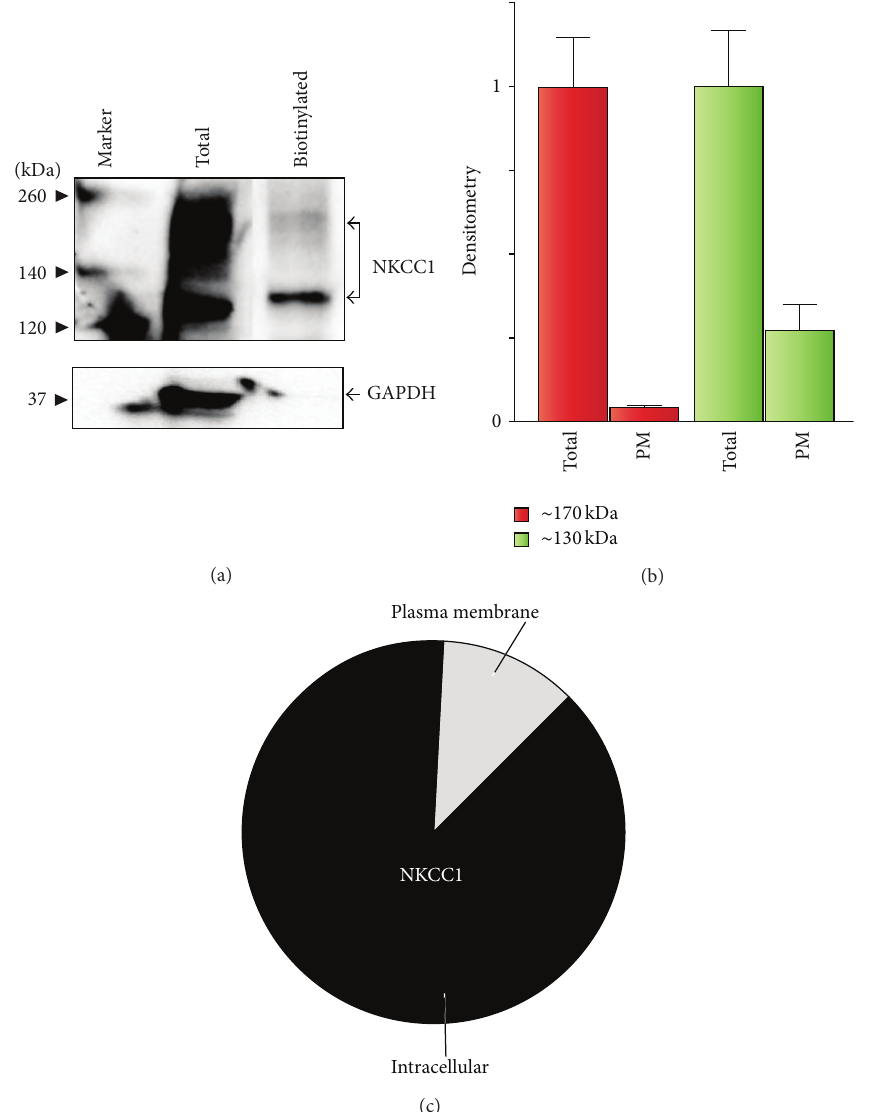
Figure 4: A small proportion of total NKCC1 locates in the plasma membrane. (a) Representative NKCC1 immunoblot of equal amounts of total protein extracts and plasma membrane biotinylated fractions obtained from COS7 cells growing under normal conditions. Shown are bands of expected sizes of NKCC1, that is, ∼ 170kDa and ∼ 130kDa, in total cellular extracts and in biotinylated plasma membrane fractions. Protein expression of cytosolic GAPDH was used as a loading control for total protein lysates and to assess the purity of biotinylated plasma membrane fractions. (b) Densitometry analysis of immunoblots showing estimated levels of the two main immunobands of NKCC1: core/high-mannose ∼ 130kDa (green bars) and complex/hybrid ∼ 170kDa (red bars) in total lysates or biotinylated plasma membrane fractions. Data is expressed as the mean ± SEM ( 𝑛 = 3 ). (c) Pie-chart representation of the estimated, relative contribution of total NKCC1 to the plasma